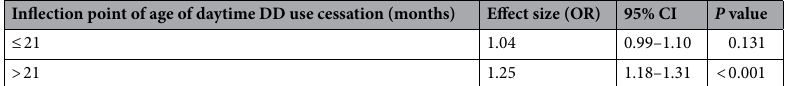
Inflection point of age of daytime DD use cessation